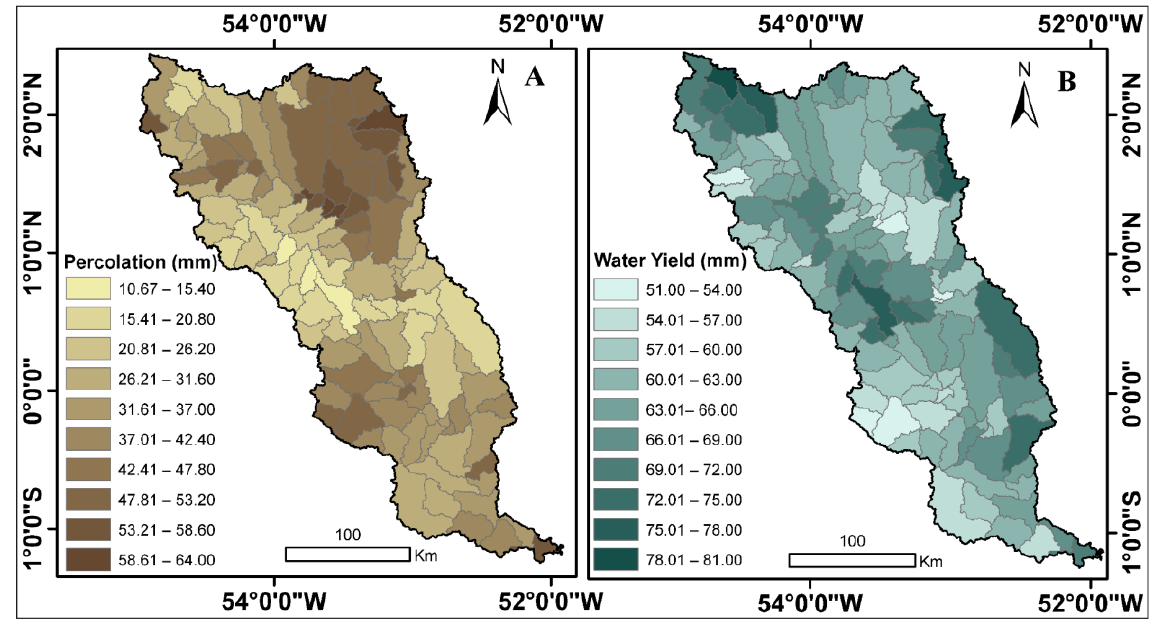
Figure 8. Spatial distribution of percolation ( A ) and water yield ( B ) simulation results.